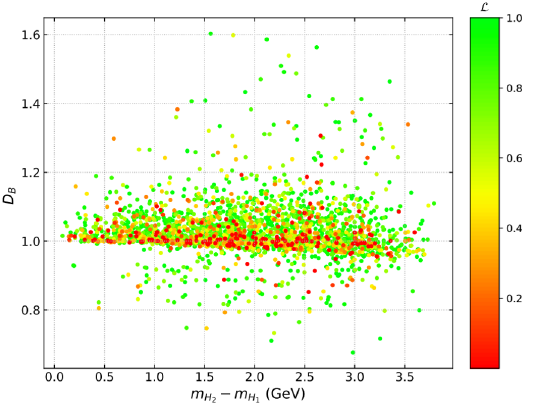
versus D − m H B 2 1